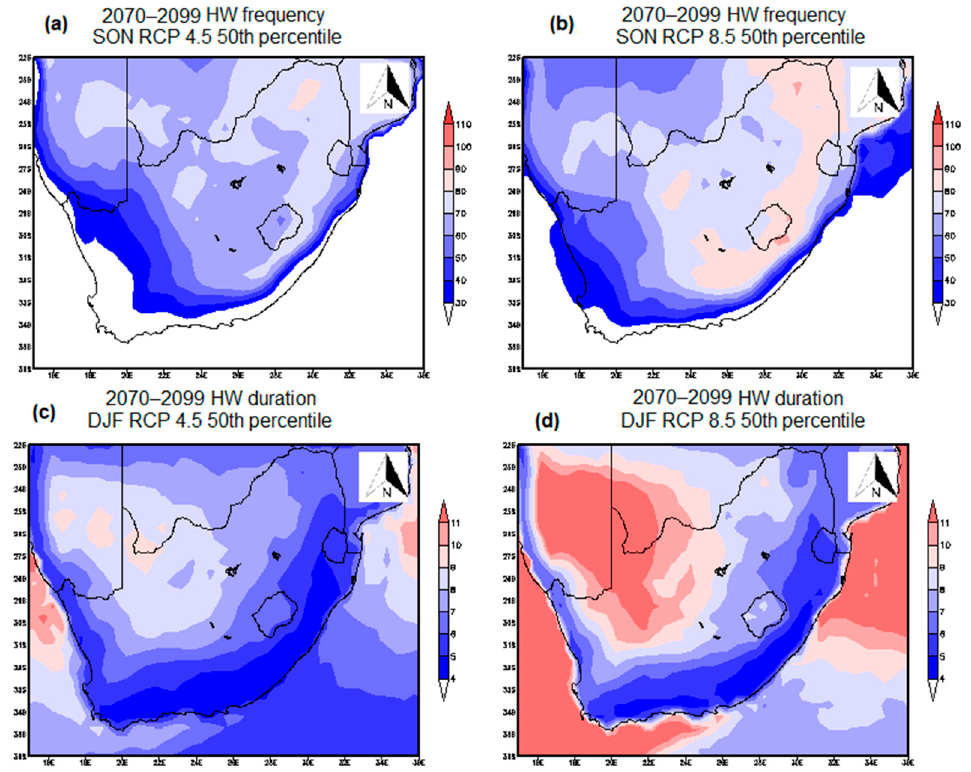
Figure 9. Simulations of SON HW frequency (total number of occurrence) 50th percentile for ( a ) 2070–